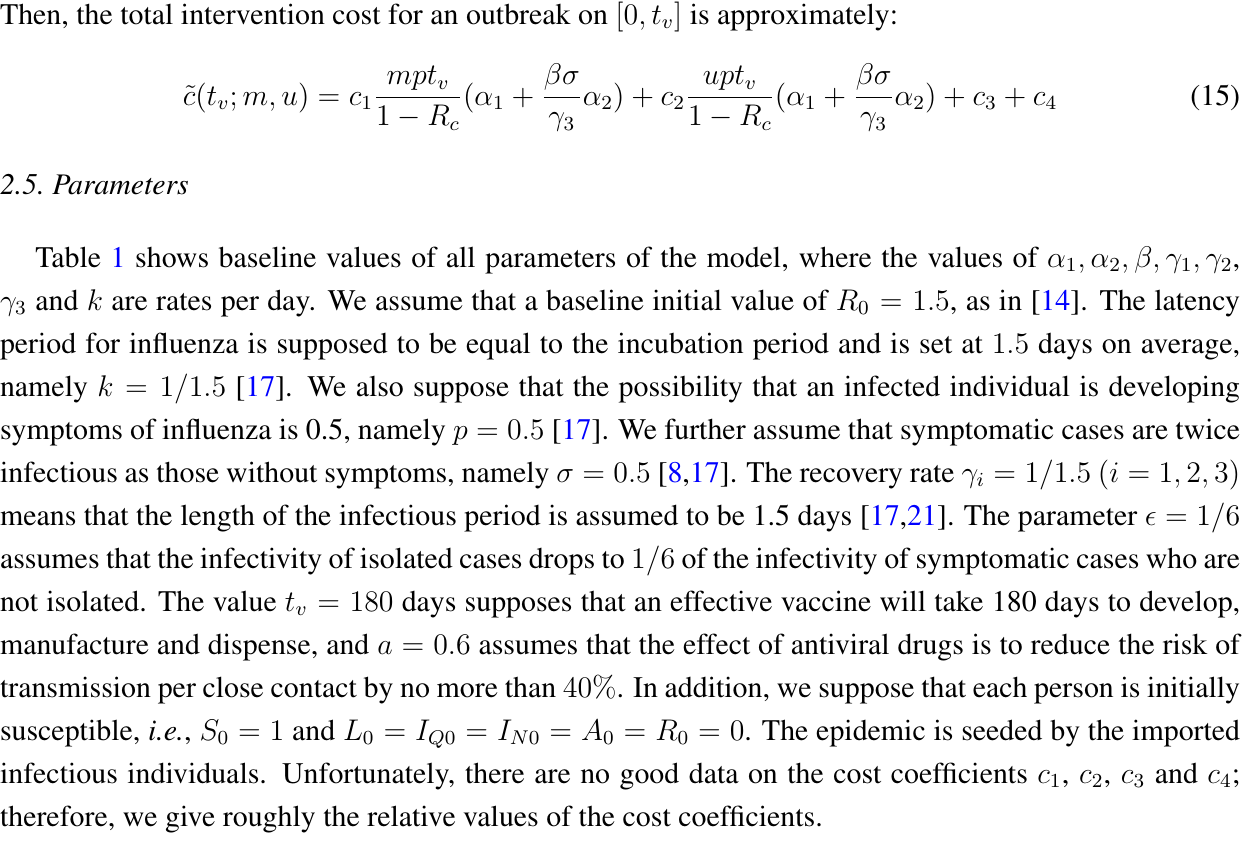
Table 1. Baseline values for model